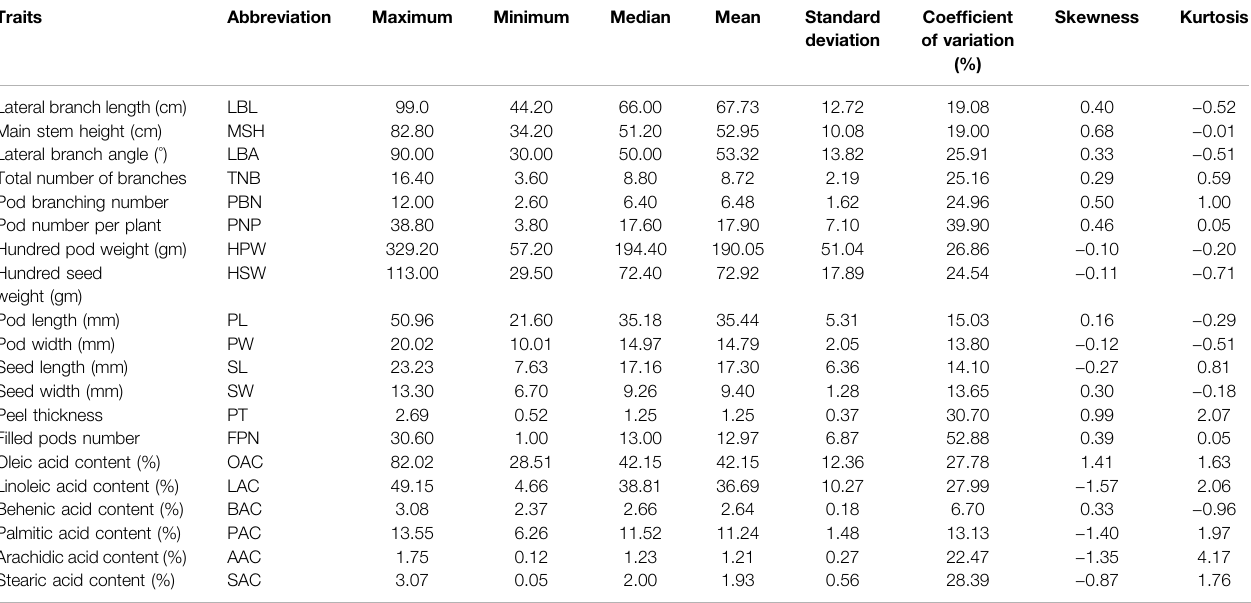
TABLE 1 | Phenotypic statistics of peanut major agronomic